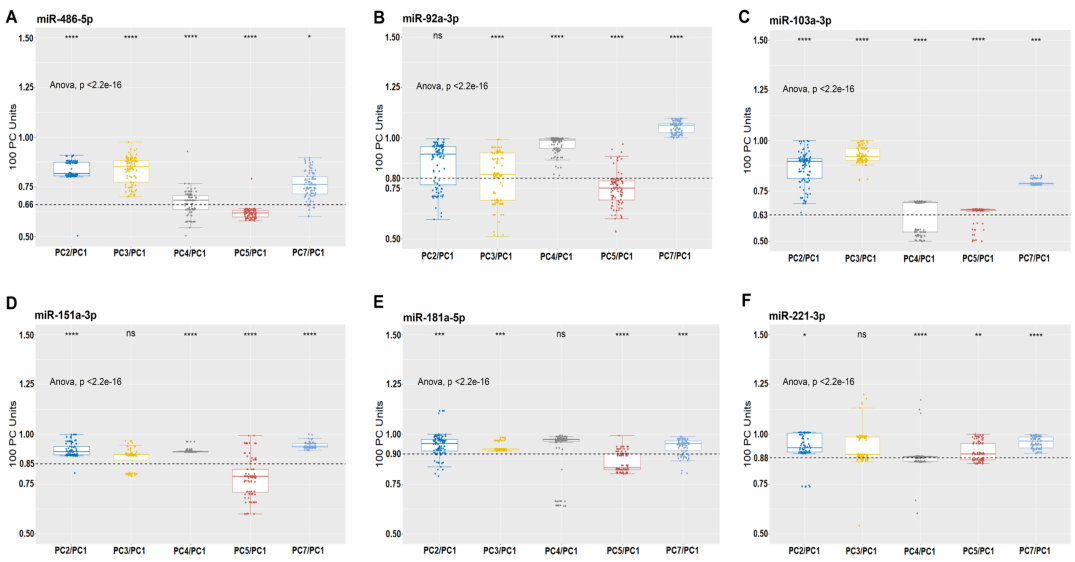
Figure 3. Relative mean expression of miRNAs (quantitative PCR (qPCR) analysis). The average expression of miR-486-5p, miR-92a-3p, miR-103a-3p, miR-151a-3p, miR-181a-5p, and miR-221-3p decreased from PC-4 to PC-5 and increased only on PC-7. ANOVA was applied in multiple comparison tests to estimate the significance of the relative mean of miRNAs in 100 PC units. (ns, not significant, * p < 0.05, ** p < 0.01, *** p = 0.001, **** p < 0.0001). In all graphs, the X-axis represents the storage time of the PCs, and the Y-axis represents the 100 PC